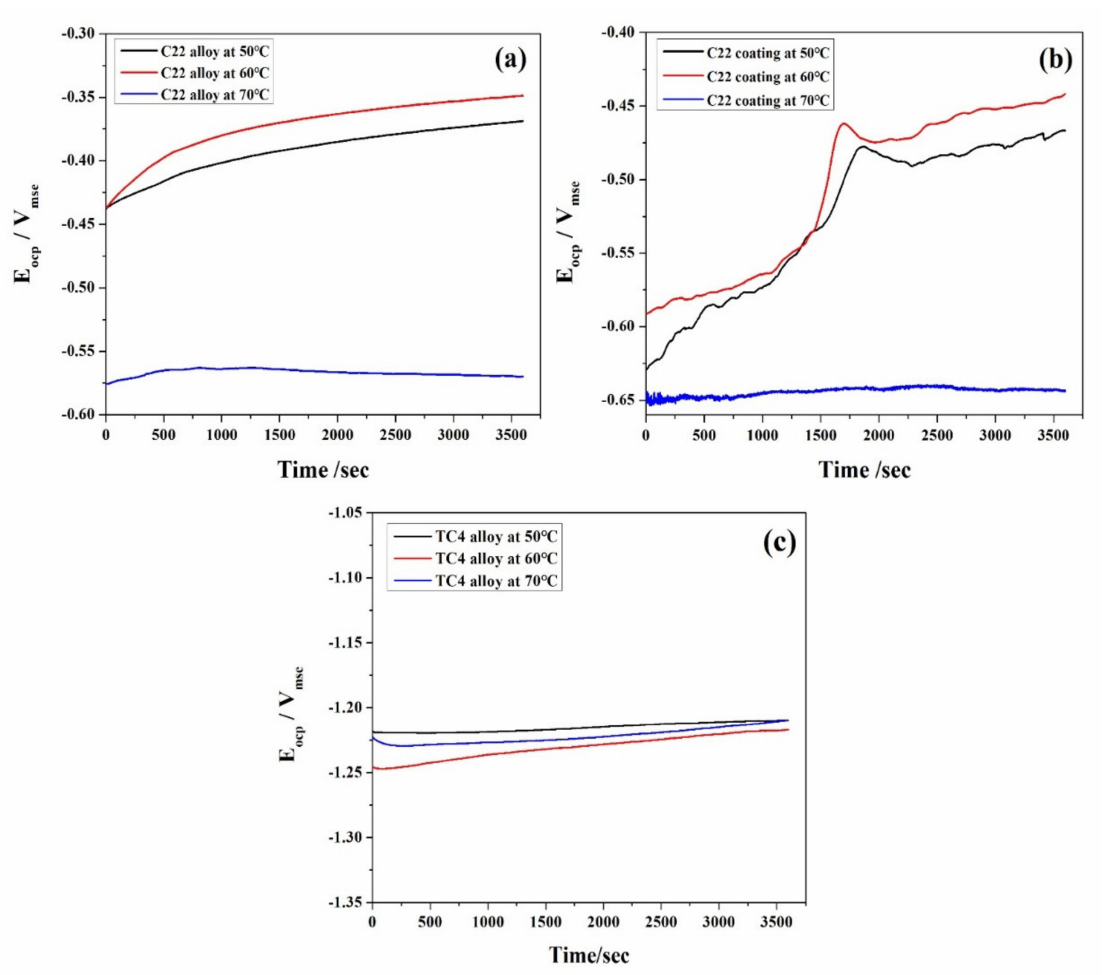
Figure 1. Open circuit potential of the C22 alloy ( a ), C22 coating ( b ), and TC4 alloy ( c ) in 50 wt.% H 2 SO 4 at 50–70 ◦